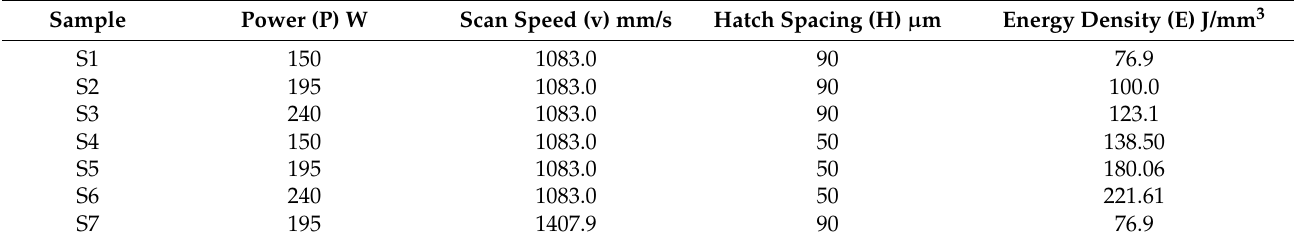
Table 1. The LPBF parameters used to manufacture the different